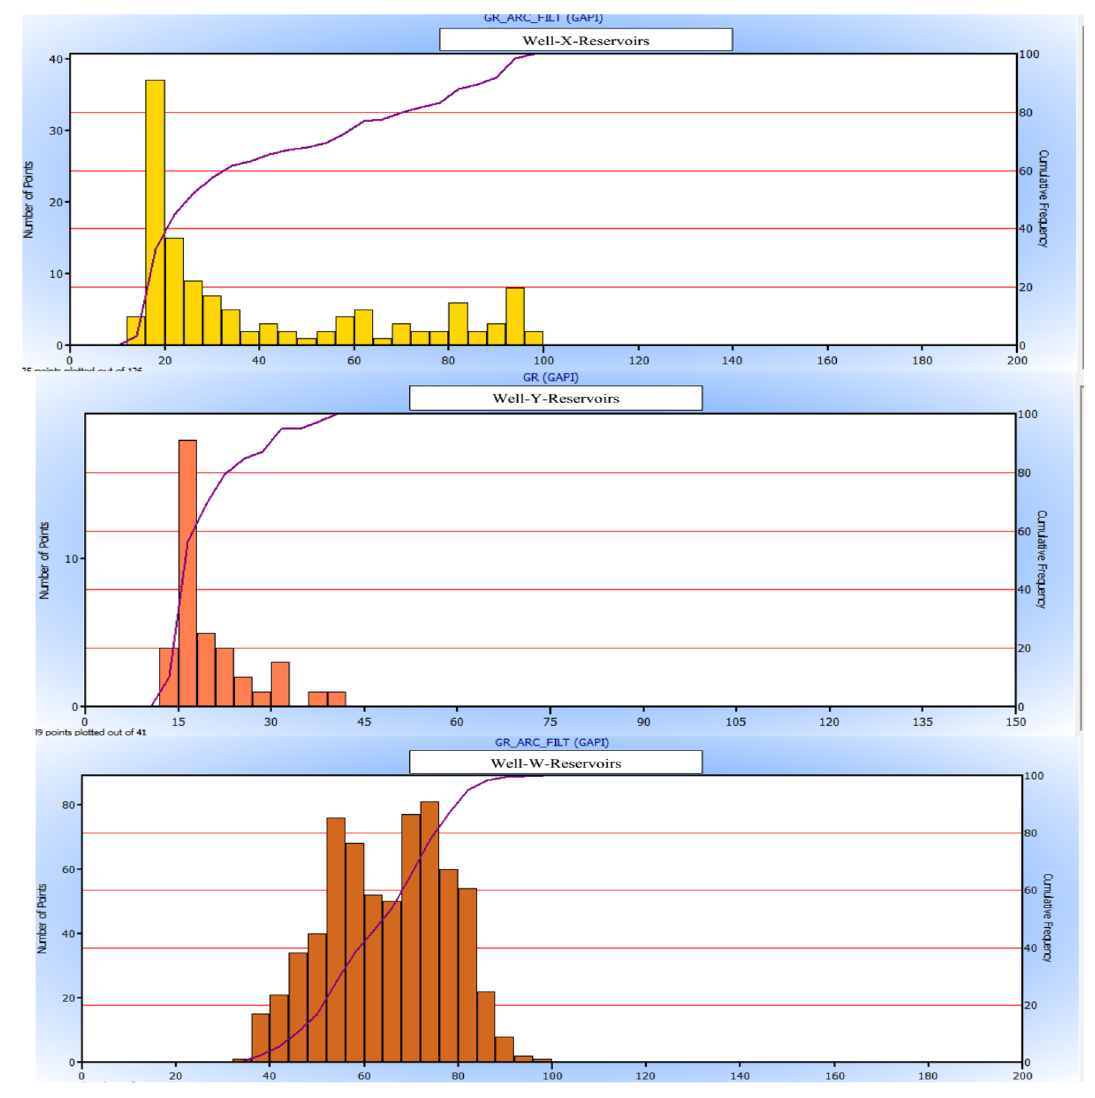
Fig. 11 GR_Histograms for Well X, Y and W reservoirs showing cleanliness of the reservoirs with respect to the GR